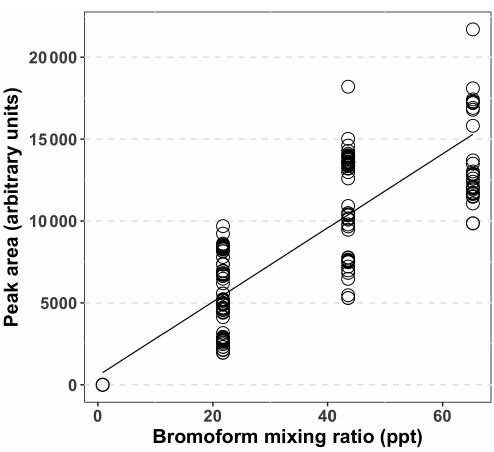
Figure 2. Combined calibration data for the GC-ECD system for bromoform, based on multiple loop injections and interpolation over the entire sampling period. Peak area calculated using the trapezoid